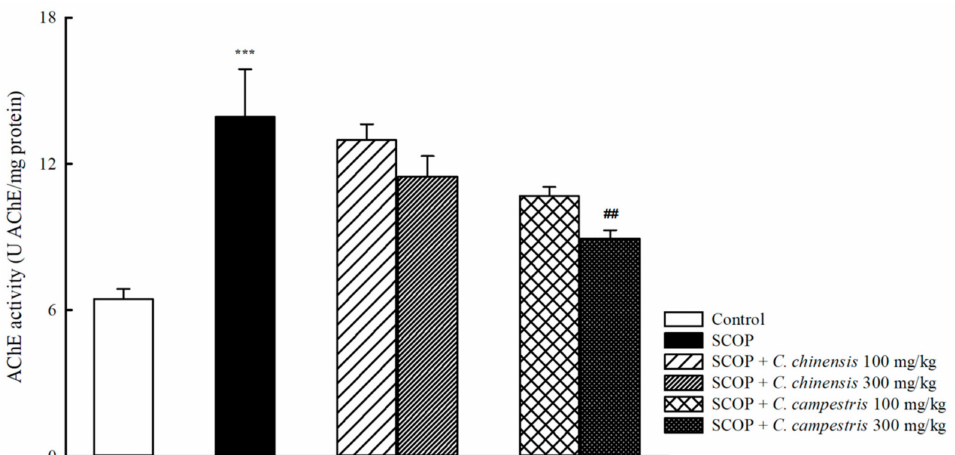
Figure 5. The effects of Cuscuta chinensis and C. campestris extracts (100 and 300 mg/kg, po) on brain acetylcholinesterase (AChE) activities in scopolamine (SCOP, 1 mg/kg, ip)-treated mice. All the brain tissues were collected from the tested mice and then homogenized to obtain the total brain homogenates. AChE activities in the total brain homogenates were subsequently examined. Columns indicate mean ± SEM ( n = 7). *** p < 0.001 compared with the SCOP group. ## p < 0.01 compared with the SCOP group.